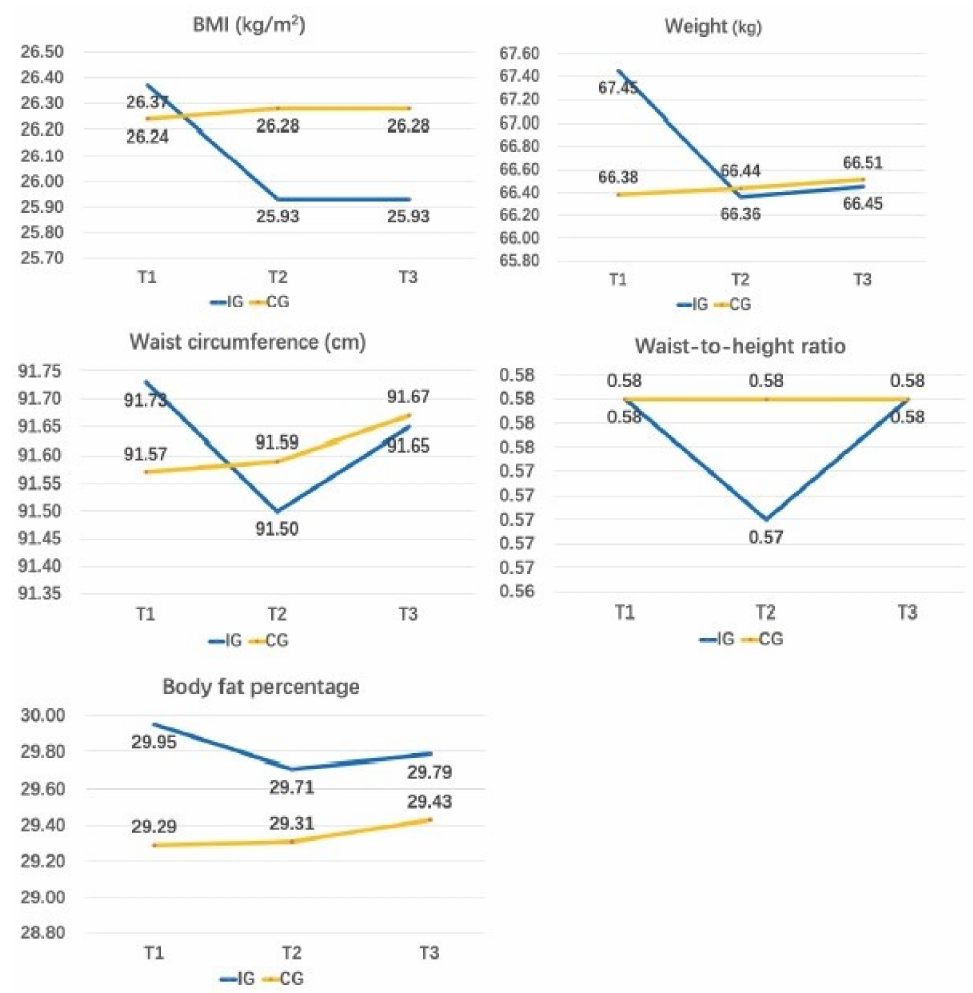
Figure 2. Changes in obesity-related outcomes across the three-time